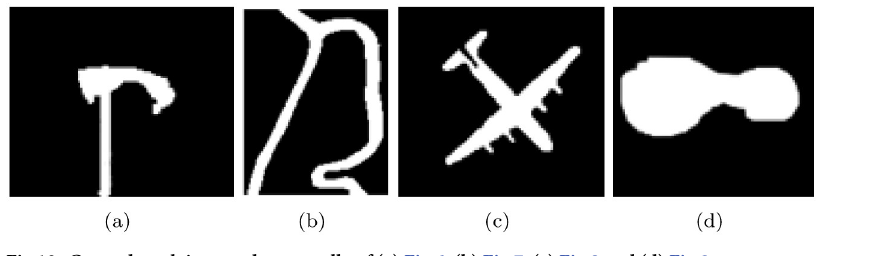
Fig 10. Ground truth invented mannually of (a) Fig 6, (b) Fig 7, (c) Fig 8 and (d) Fig 9.